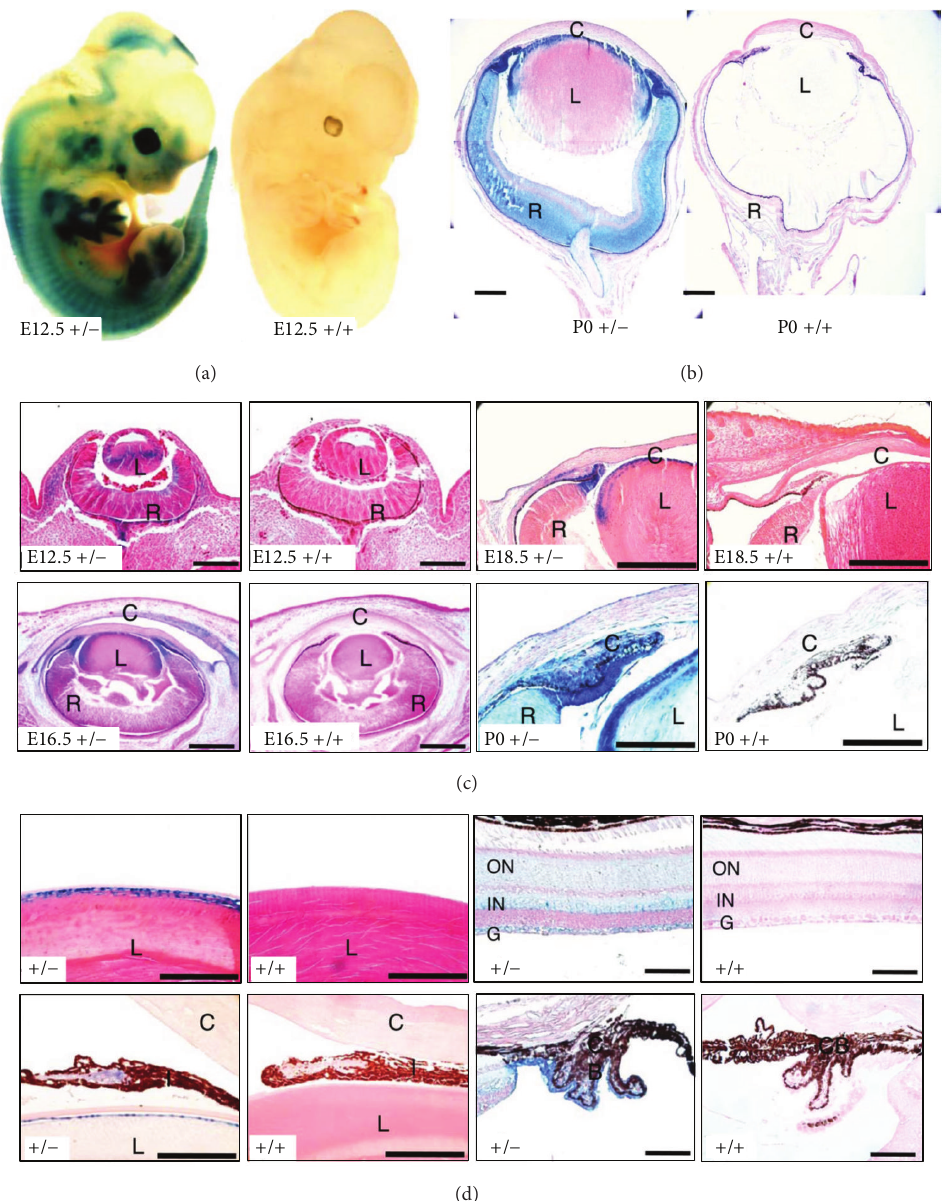
Figure2:TemporalandspatialexpressionofLgr4inmouseeyes.(a)ExpressionofLgr4atembryonicdayE12.5using 𝛽 -galactosidasestaining in Lgr4 heterozygous (+/ − ) and wild-type control (+/+) mice. (b) Expression of Lgr4 at postnatal day 0 (P0). Scale bar = 170 𝜇 m. (c) Temporal expression of Lgr4 during different stages of anterior segment development. At E12.5 days, Lgr4-expressing mesenchymal cells are located between the surface ectoderm and the lens and the inner layer cells of the optic cup. At E16.5–E18.5, Lgr4 expression is high at the tips of the optic cup and in the surrounding mesenchymal tissue. In newborn embryos, Lgr4 is highly expressed in the iris stroma, ciliary body, corneal epithelium, keratocytes, and endoepithelial cells. Wild-type (+/+) mice lack expression of 𝛽 -galactosidase. Scale bars = 170 𝜇 m. (d). Expression of Lgr4 in adult mouse tissue. Staining was found in lens epithelial cells, retinal ganglion cells, inner nuclear layer, iris stroma, and the outer layer of the ciliary body. C: cornea; I: iris; R: retina; L: lens; CB: ciliary body; G: ganglion cells; IN: inner nuclear layer; ON: outer nuclear layer. Scale bars = 85 𝜇 m. Originally published PNAS 105(16): 6081-6. Copyright 2008 National Academy of Sciences USA.